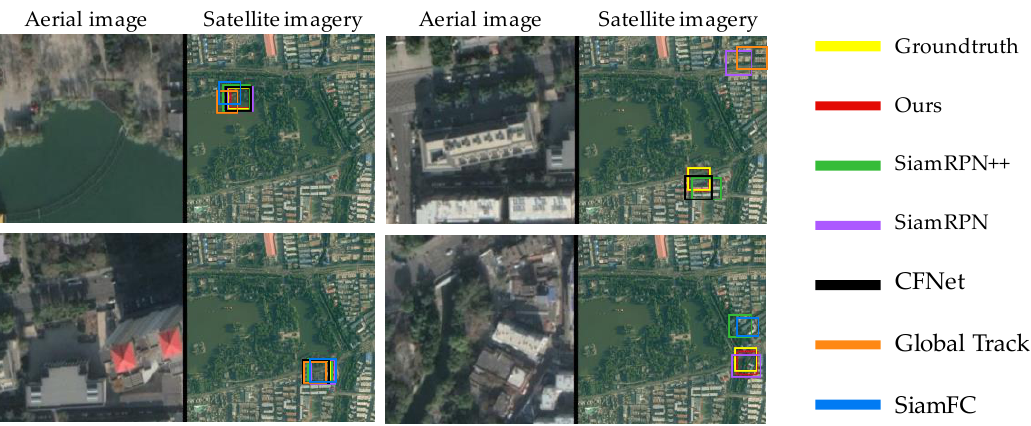
Figure 12. Qualitative comparison of M-O SiamRPN with multi-optimization and state-of-the-art frameworks.